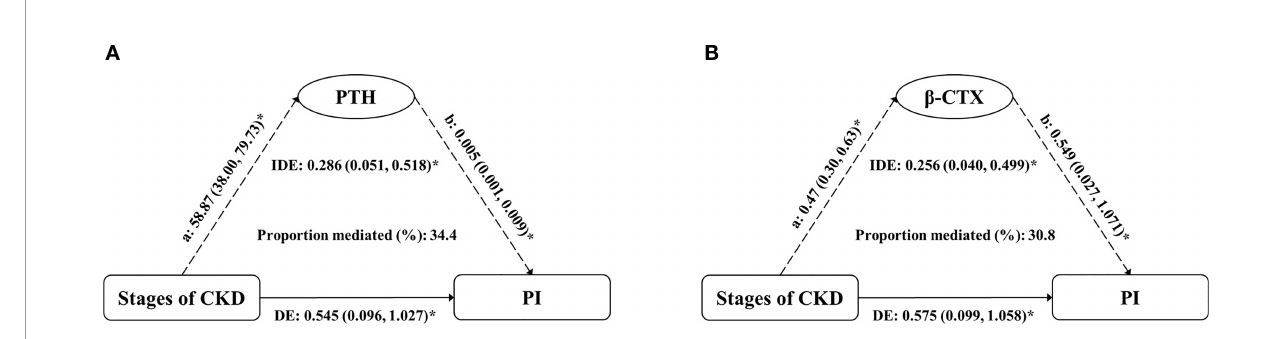
FIGURE 3 | Estimates of the mediation effect of (A) PTH and (B) b -CTX about the association between the stages of CKD and PI value, after adjusting for age, sex and BMI. Note: (A) the effect of grouping on mediator; (B) the main effect of mediator on PI; IDE, indirect effect (Stages of CKD ! PTH/ b -CTX ! PI); DE, direct effect (Stages of CKD ! PI); PTH, parathyroid hormone; b -CTX, b -CrossLaps; PI, porosity index. *P